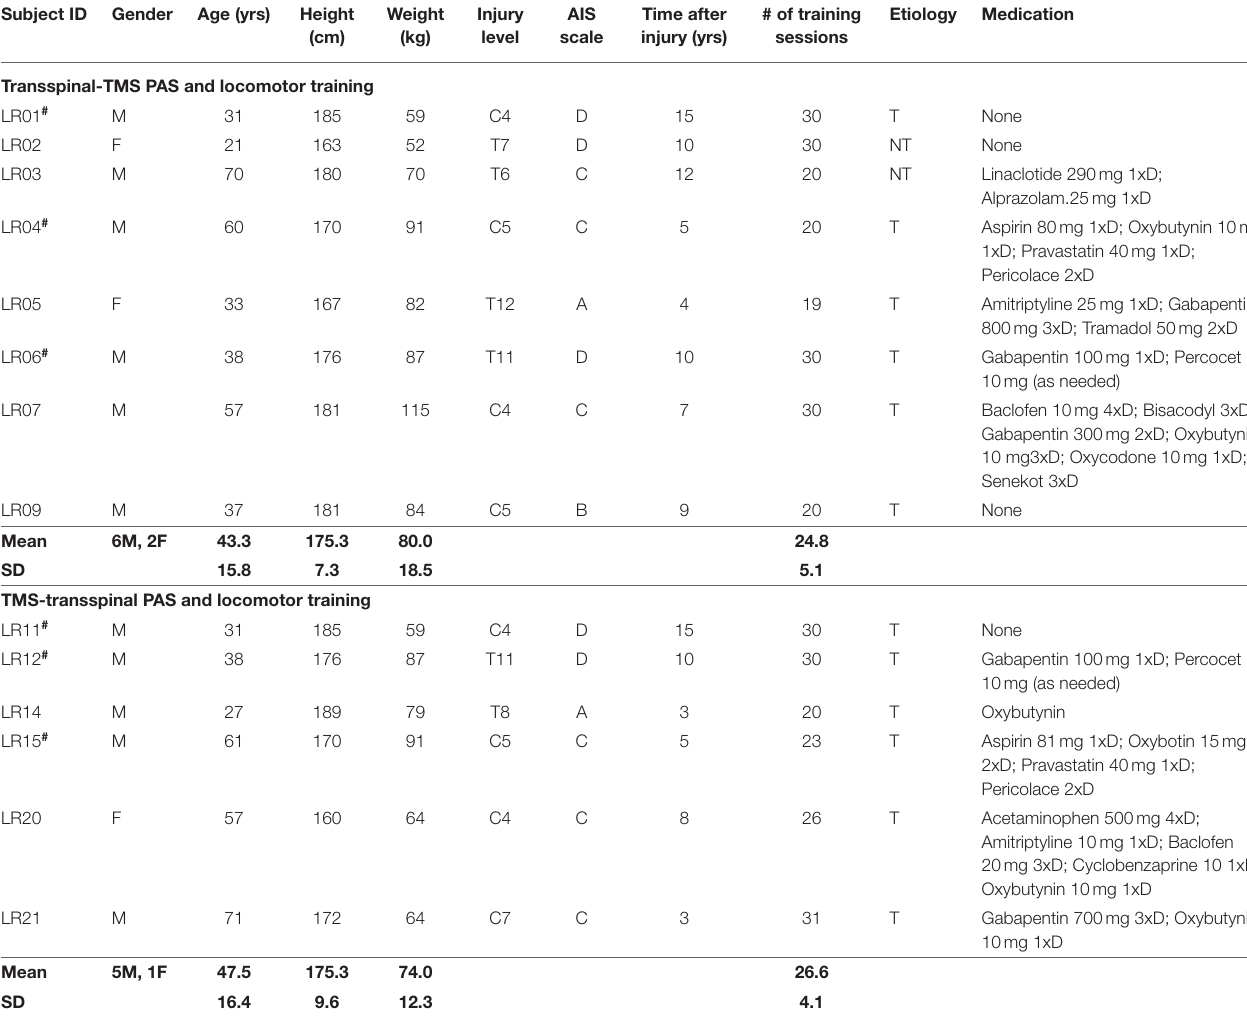
TABLE 1 | Participant